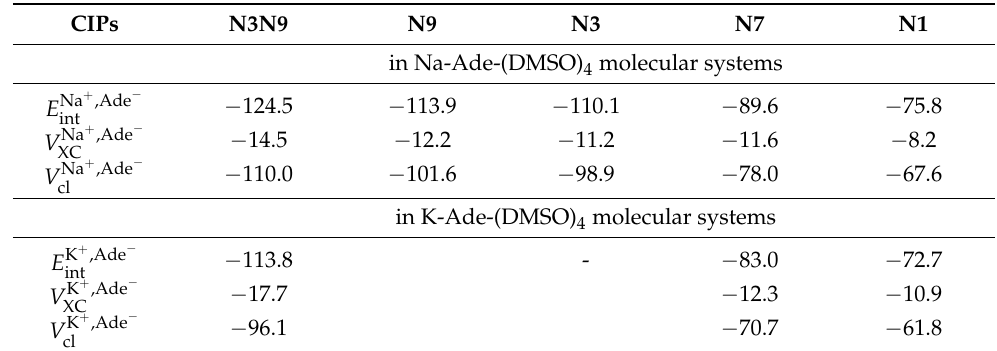
Table 5. The total inter-ionic interaction energy, E M + ,Ade − trostatic, V M , components computed for the indicated M-Ade complexes within the M-Ade- cl (DMSO) 4 molecular systems. All values are in kcal mol − 1 .